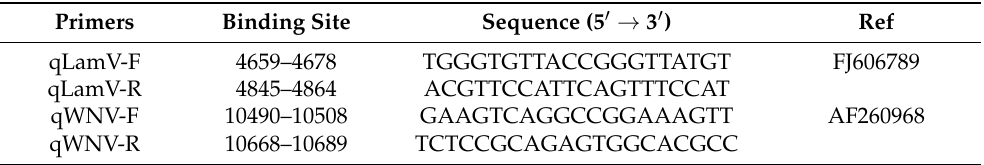
Table 5. Primer pairs used for qPCR